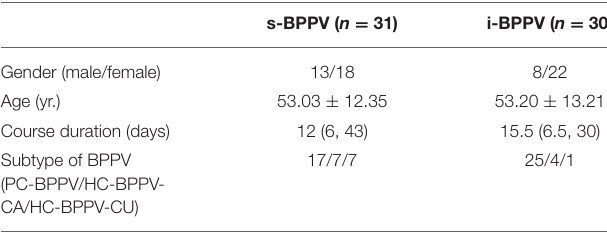
TABLE 1 | Demographic and clinical characteristics of patients with s-BPPV and